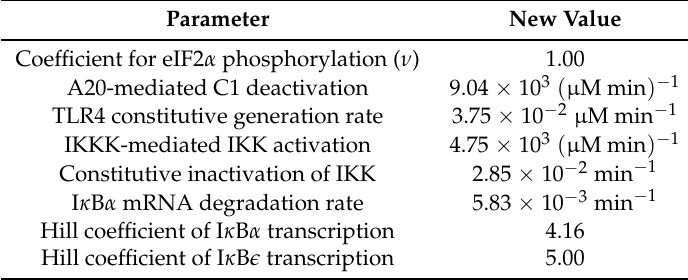
Table 2. Selected parameters and their newly estimated values for the final